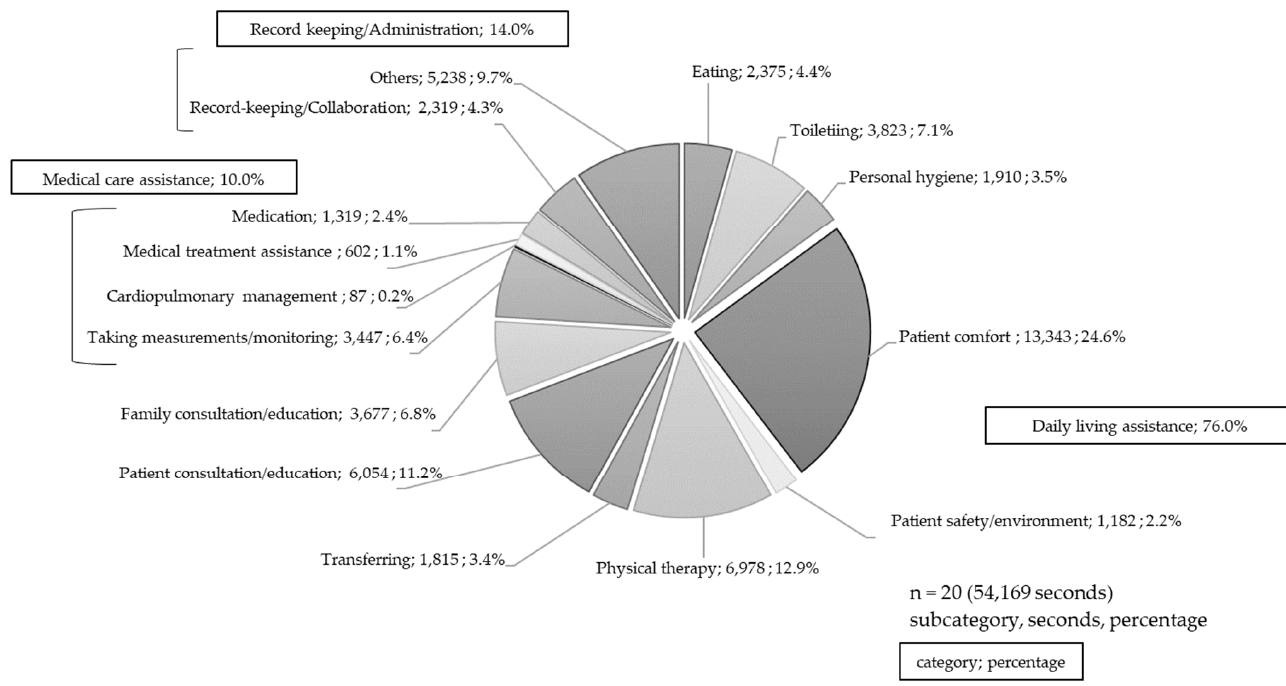
Figure 1. Ration of nursing care times.